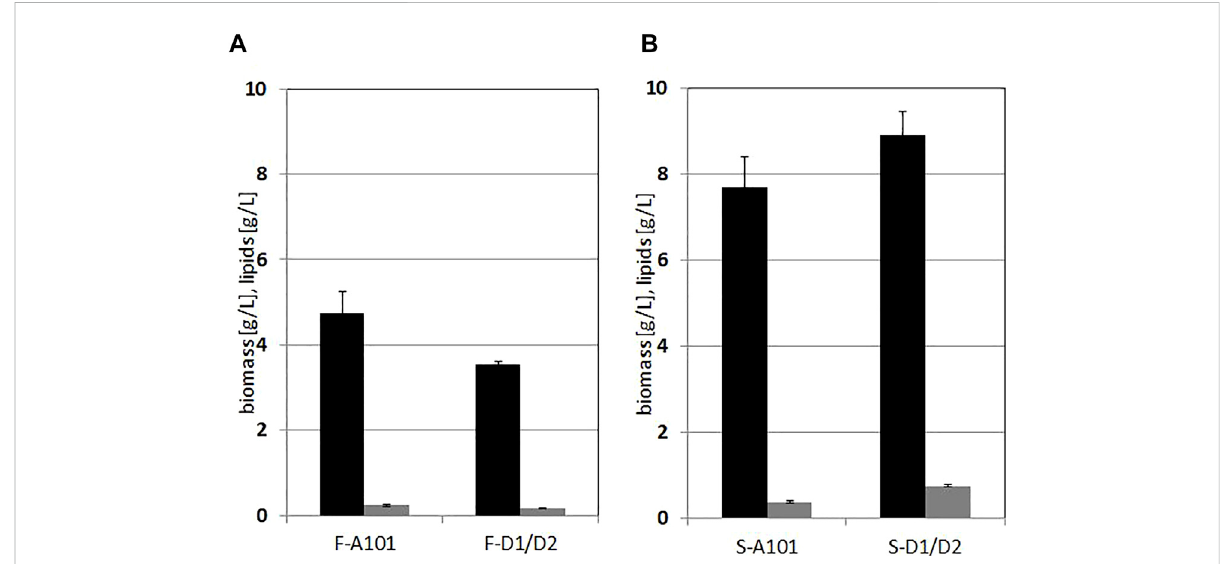
FIGURE 4 Lipid (grey bars) and biomass (black bars) production by Y. lipolytica A101 and AJD DGA1/DGA2 strains grown on F vesiculosus — (A) and S. latissima (B) hydrolysates. Cells were grown 72 h in 250 ml fl asks at 28 ° C, with 200 rpm shaking in 50 ml medium. Error bars indicate SD from three biological repetitions.